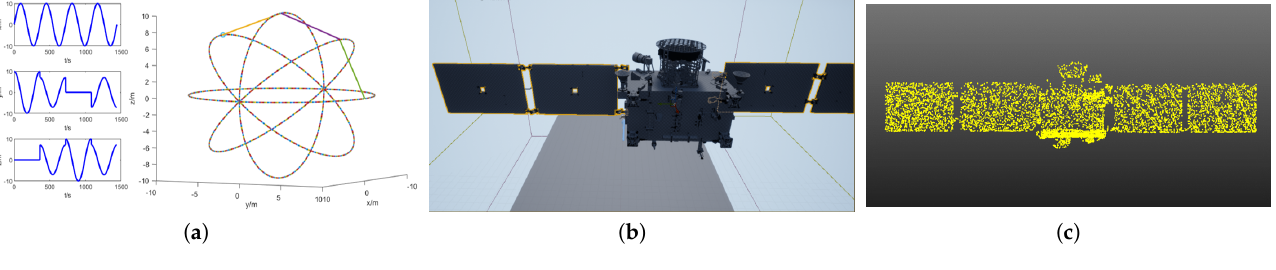
Figure 3. Airsim simulation system: ( a ) Airsim simulated trajectory. ( b ) Airsim simulated trajectory. ( c ) Airsim simulated point cloud.